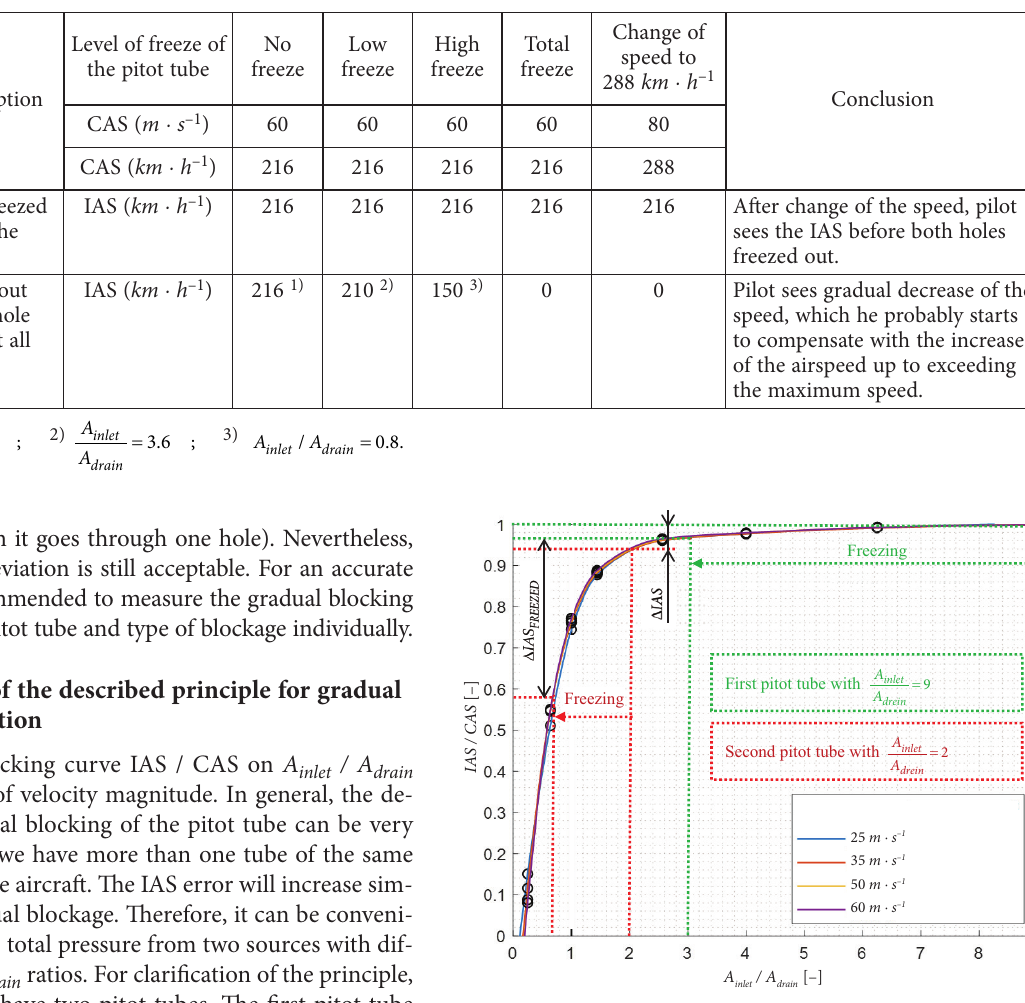
Table 6. Freezing of the pitot tube scenario